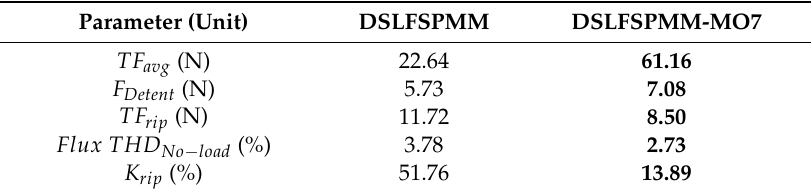
Figure 23. Performance comparison of DSLFSPMM and DSLFSPMM-MO7. Table 15. Performance comparison of DSLFSPMM and DSLFSPMM-MO7.